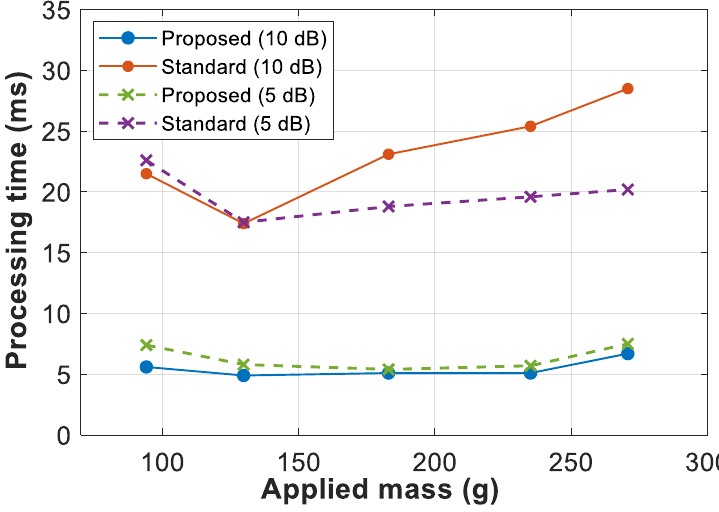
Figure 7. Mean processing time of double-Gaussian fitting based on the standard and proposed approaches, when having 10 dB SNR (straight lines) and 5 dB SNR (dashed lines). Values were obtained averaging the computation time over 100 repeated measurements at each applied mass. Table 1. Comparison of the average number of iterations and computation time (in brackets) of double-Gaussian fitting based on the standard and proposed approaches. Values correspond to the average obtained over 100 measurements for the processing of a single local BGS (at the strained transition location), running Matlab R2019b (Windows 10 Pro) in an Intel(R) Core(TM) i7- 9750H CPU @2.6GHz with 32 GB RAM.